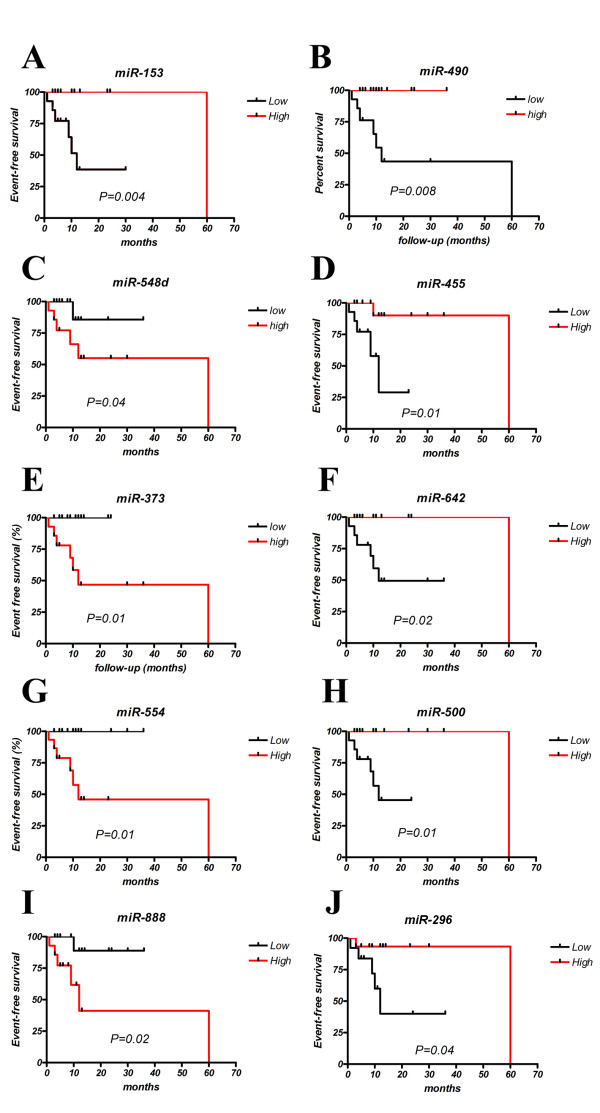
Kaplan-Meier survival curves of EFS in MM patients based on high or low (median) expression levels of microRNAs (P < 0.05). Curves were compared by univariate (logrank) analysis. (A) miR-153, (B) miR-490, (C) miR-548d, (D) miR-455, (E) miR-373, (F) miR-642, (G) miR-554, (H) miR-500, (I) miR-888 and (J) miR-575.